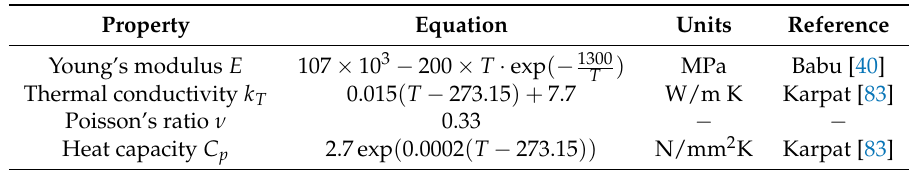
Figure 8. Particles used at the end of the numerical simulation. The Johnson-Cook constitutive model was used with the parameters with parameters 7. Table 3. Thermo physical properties of Ti6Al4V used in the simulations with the Johnson-Cook and dislocation density model (the temperature is given in Kelvins).